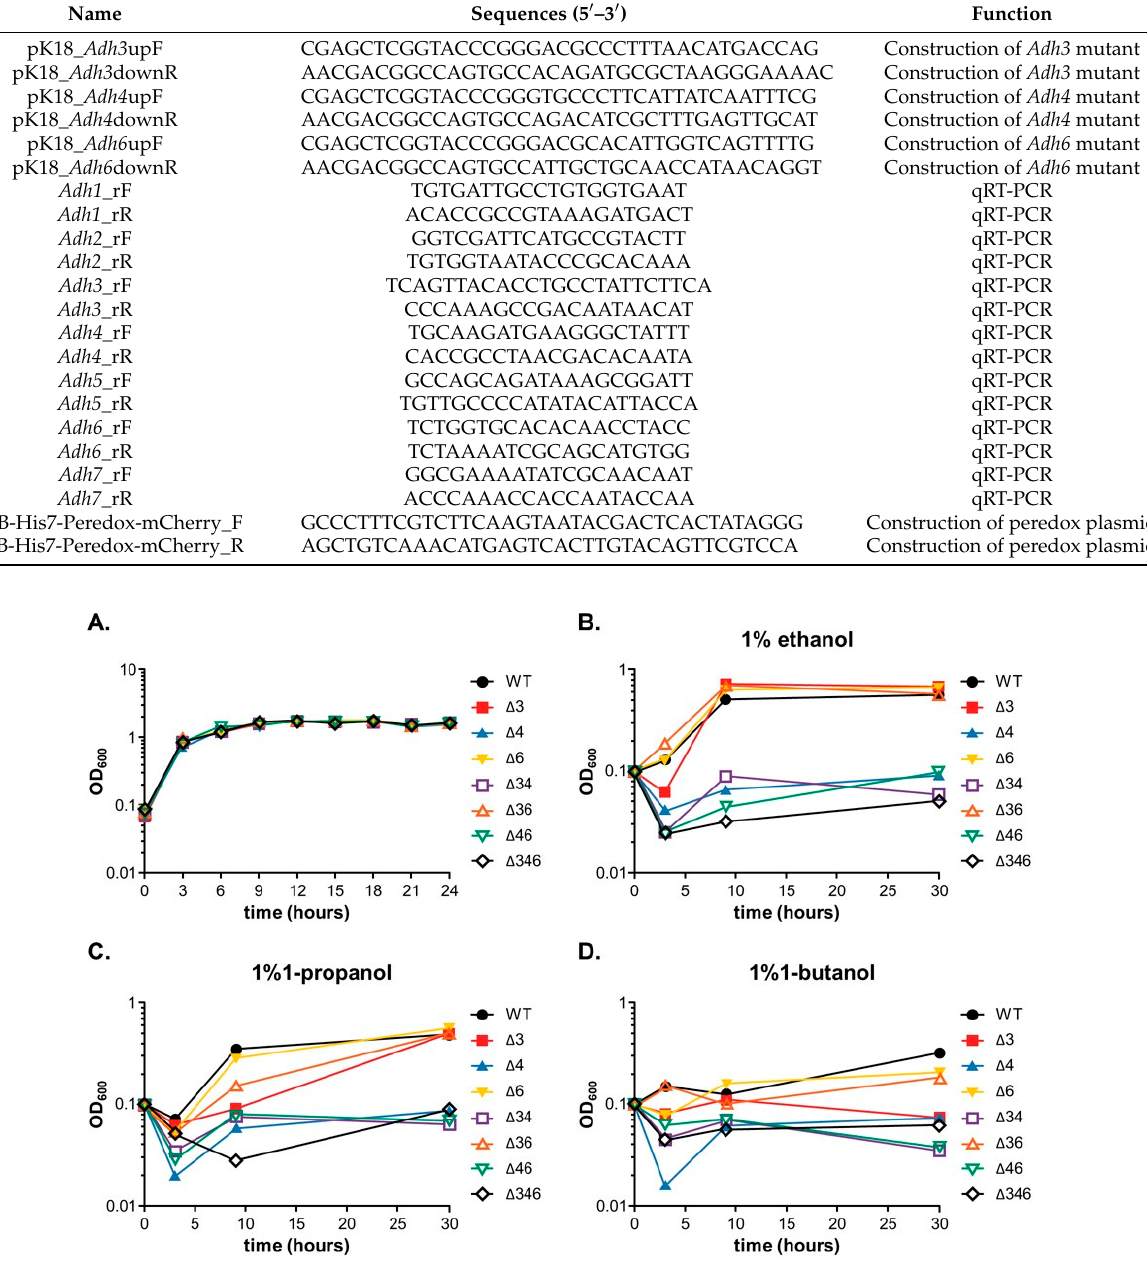
Figure 3. Growth rates of wild-type (WT) or mutant strains in different medium. ( A ) Growth rates in LB medium. ( B ) Growth rates in M9 medium containing 1% ethanol. ( C ) Growth rates in M9 medium containing 1% 1-propanol. ( D ) Growth rates in M9 medium containing 1% 1-butanol.